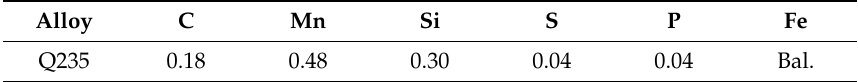
Table 1. Chemical composition of 6061 aluminum alloy (wt.%). Table 2. Chemical composition of Q235 steel (wt.%). Table 2. Chemical composition of Q235 steel (wt.%).